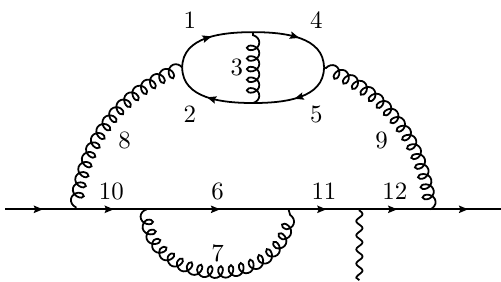
Figure 2. Example graph Γ with nested ultraviolet divergences. Its collection of UV divergent subgraphs is D (Γ) = { γ 67 , γ 123 , γ 345 , γ 1245 , γ 12345 , γ 1 ... 12 }